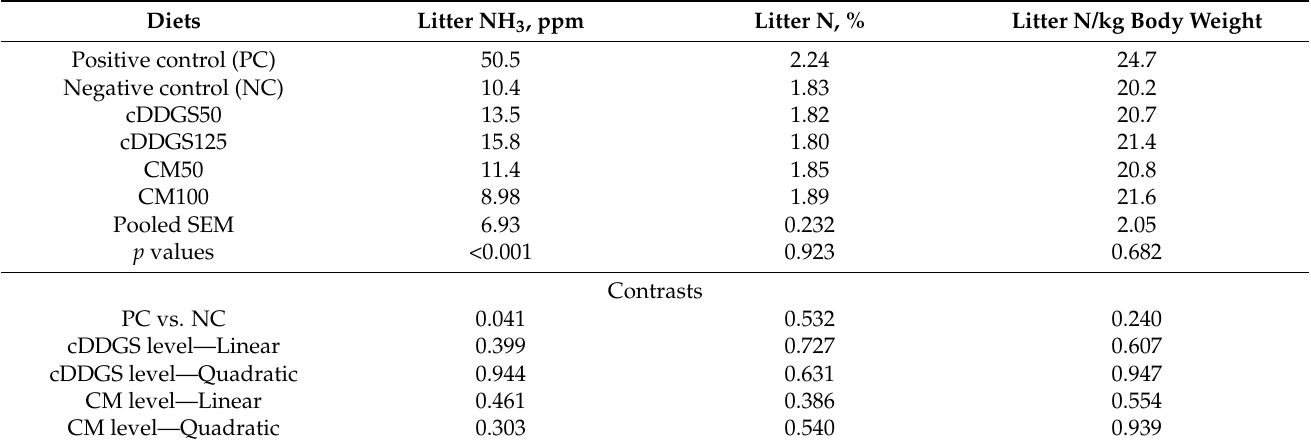
Table 11. Litter ammonia and N measured at d 42 of broilers receiving diets containing soybean with reduction in crude protein or low-protein diets with serial inclusion levels of canola meal or corn–DDGS supplemented with crystalline amino